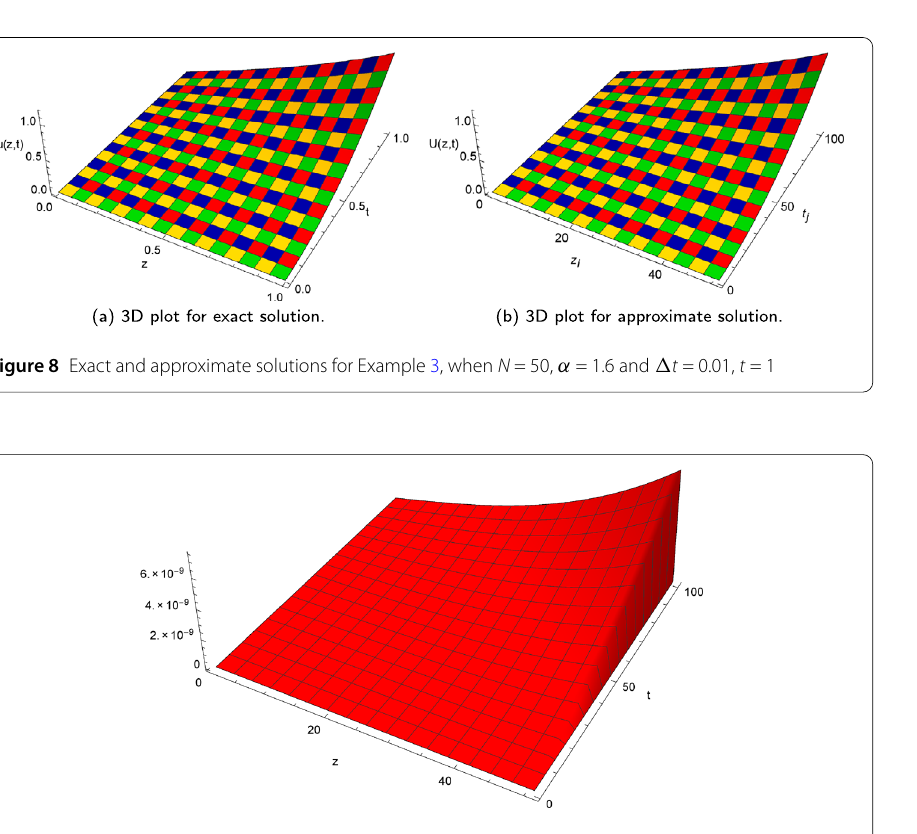
Figure 9 Absolute error graph for Example 3 at t = 1 when N = 50, α = 1.5 and 0 ≤ z ≤